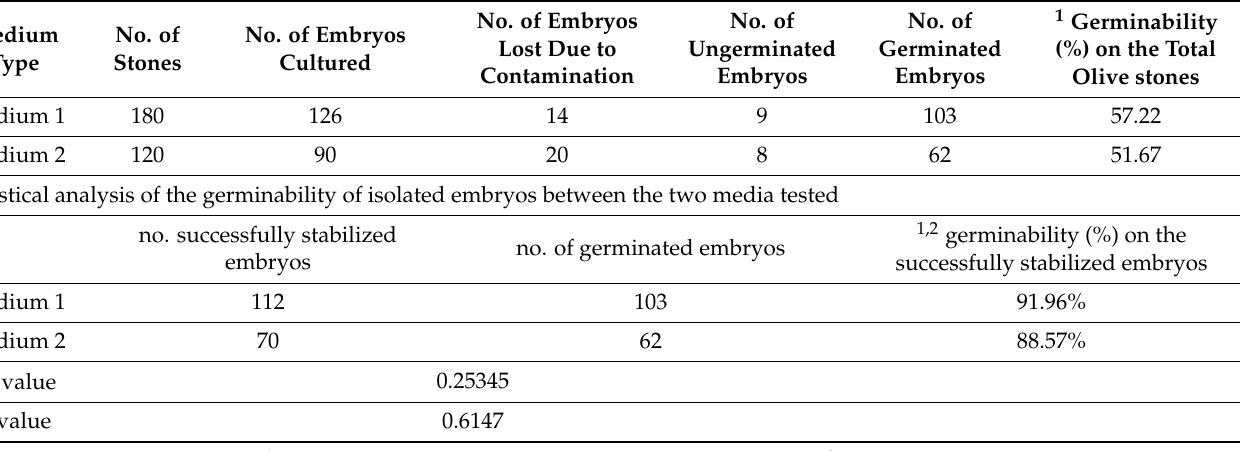
Table 4. In vitro germinability, after 3 weeks of culture, of isolated olive embryos related to the cross combinations performed in the 2019